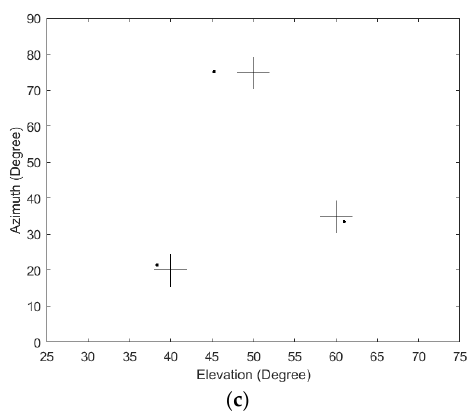
Figure 11. Scatter plots of estimated 2D angles in the presence of mutual coupling. ( a ) Classic 2D MUSIC algorithm; ( b ) PIE algorithm; ( c ) The proposed AESS algorithm.